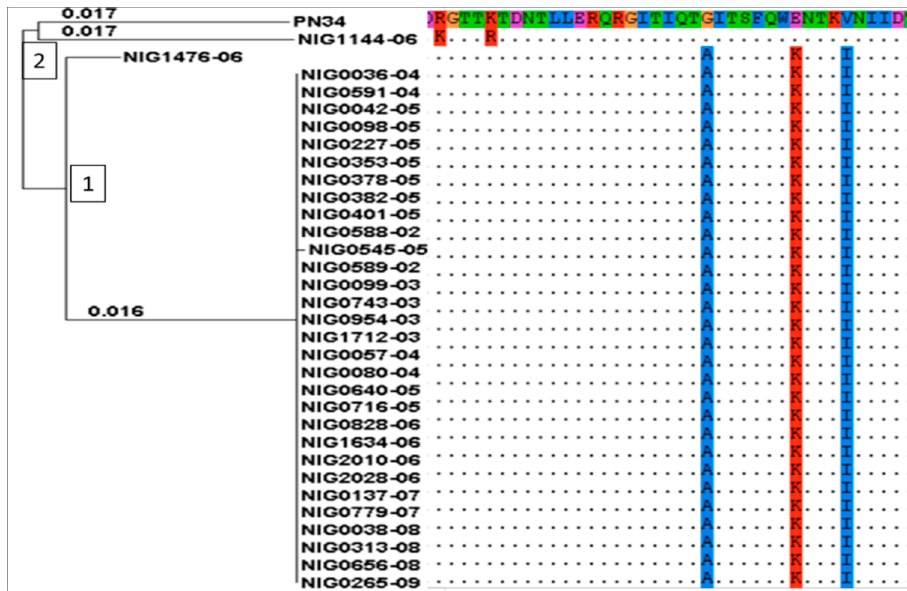
Figure 3. Evolutionary diversity of tet (M) genes from clinical serotype 1 Streptococcus pneumoniae recovered from meningitis cases between 2002 and 2009 in Niger. The analysis involved 32 tet (M) sequences and a reference sequence. PN34 (Accession number: AY466395.1). Sequence names were coded as NIG for Niger followed by isolate identity number, underscore and the year of isolation. Taxa fall in two clades each split into 2 subclades.